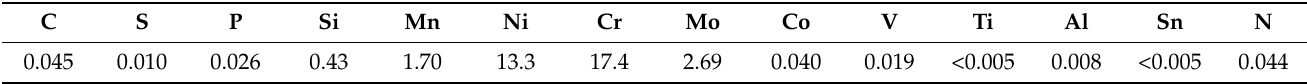
Table 1. Alloying elements (wt.%) of the Type 316L steel used in this study; balance Fe. C S P